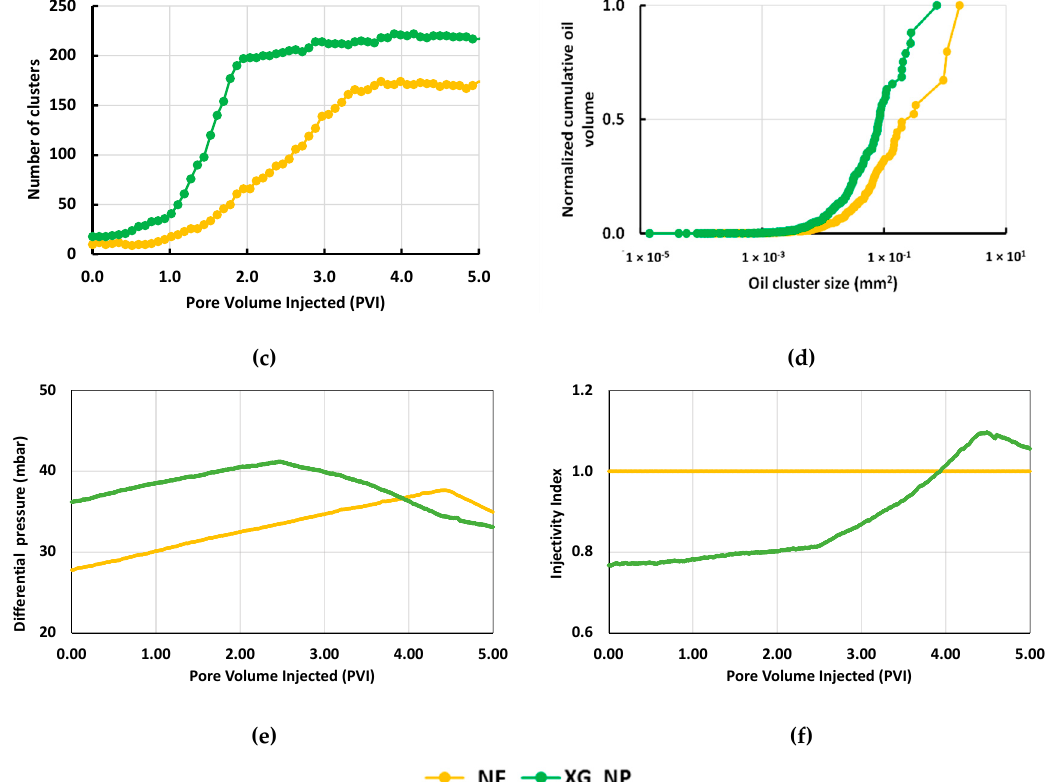
Figure 8. Microfluidic results showing the effect of a higher flow rate (0.39 µL/min) on the recovery performance: ( a ) Oil recovery factor; ( b ) Normalized Euler number; ( c ) Number of clusters; ( d ) Normalized cumulative oil volume; ( e ) Differential pressure; ( f ) Injectivity index.